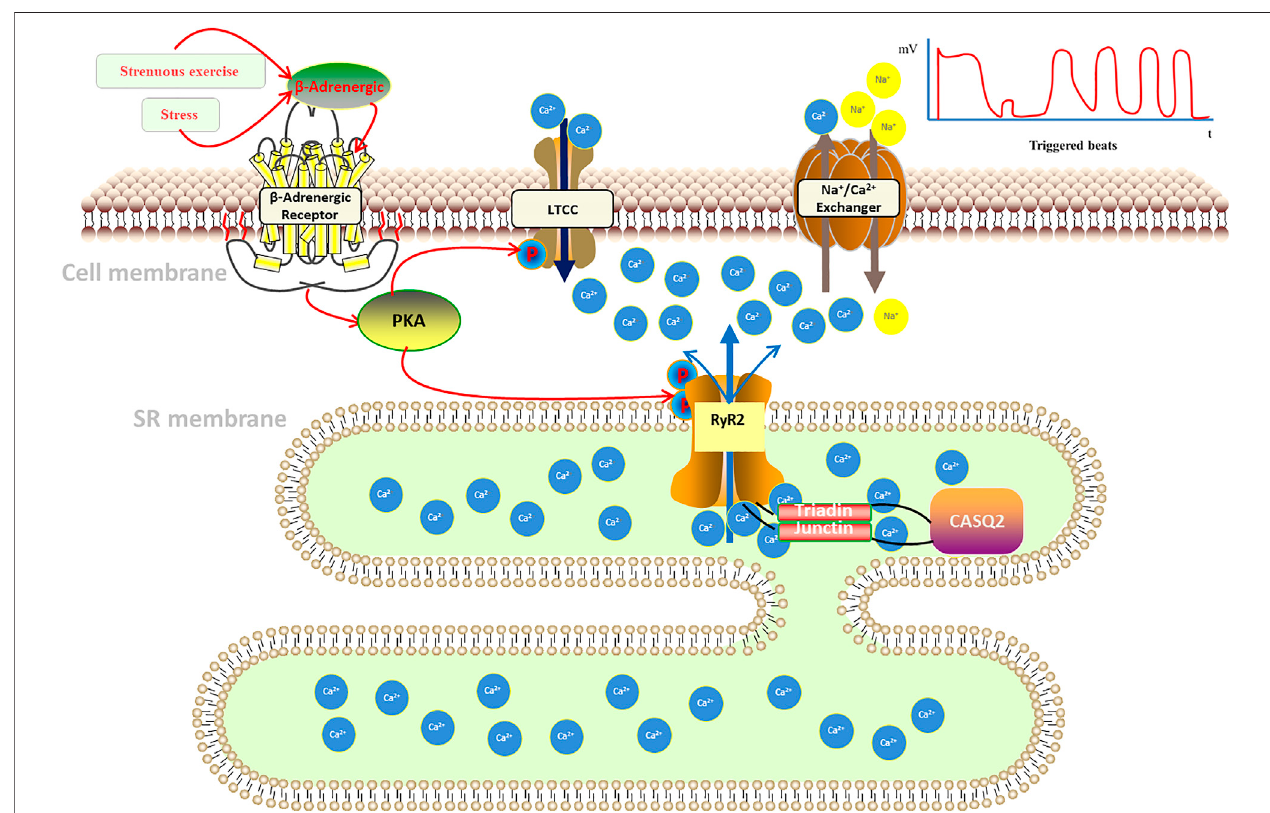
FIGURE 1 | Pathogenesis of catecholaminergic polymorphic ventricular